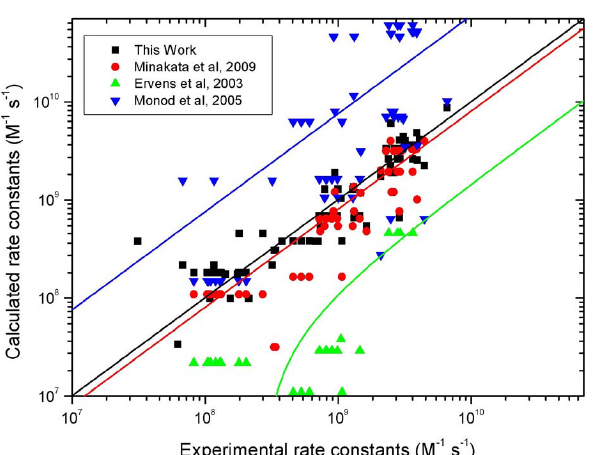
Figure 4: Correlation plot between experimental rate constants and calculated rate constants for 2 Fig. 4. Correlation plot between experimental rate constants and carbonyl compounds according to previously proposed estimation methods. The lines are the linear 3 calculated rate constants for carbonyl compounds according to pre- regression lines which parameters are given in Table 7. 4 viously proposed estimation methods. The lines are the linear re- gression lines which parameters are given in Table 7.